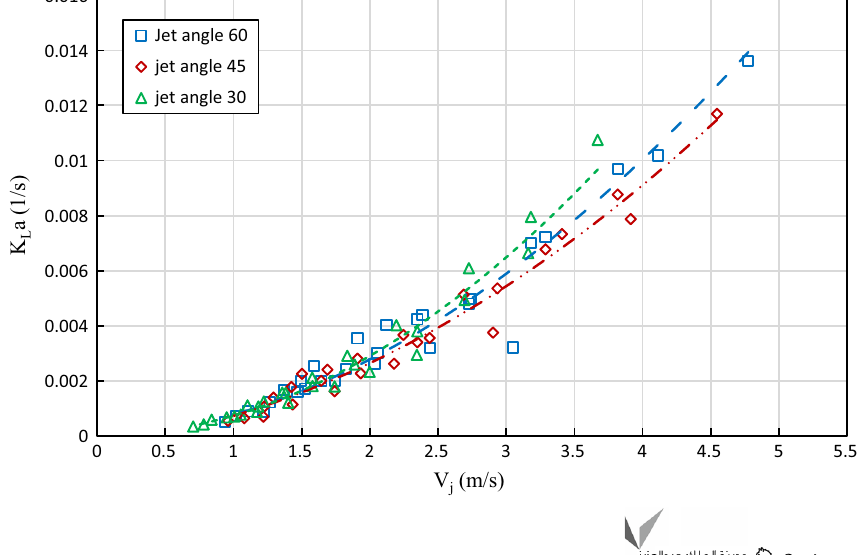
Fig. 3 Variation of volumetric oxygen transfer coefficient with jet velocity indicating the effect of jet angle (in